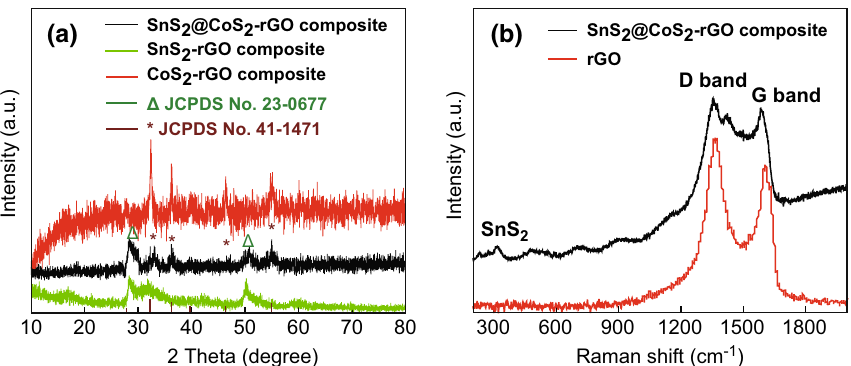
Fig. 1 a XRD patterns of the SnS 2 @CoS 2 –rGO composite, SnS 2 –rGO composite and CoS 2 –rGO composite and b Raman spectra of the SnS